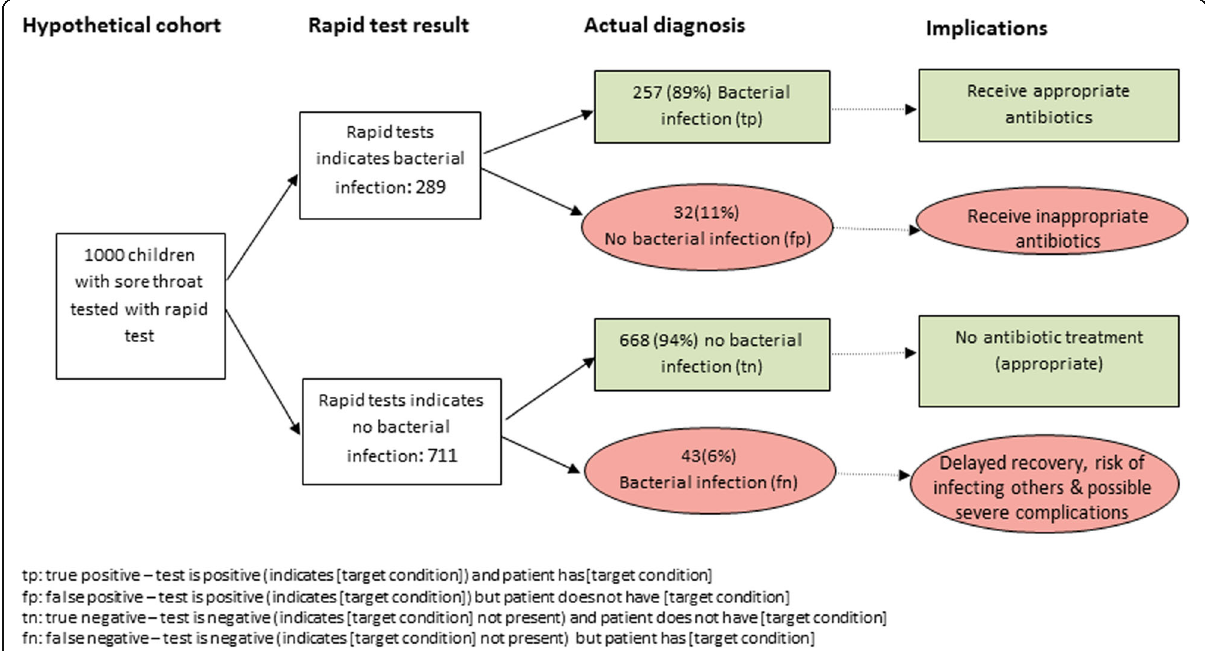
Fig. 2 Figure showing results that would be obtained if a hypothetical cohort of 1000 children were tested for strep A infection using rapid